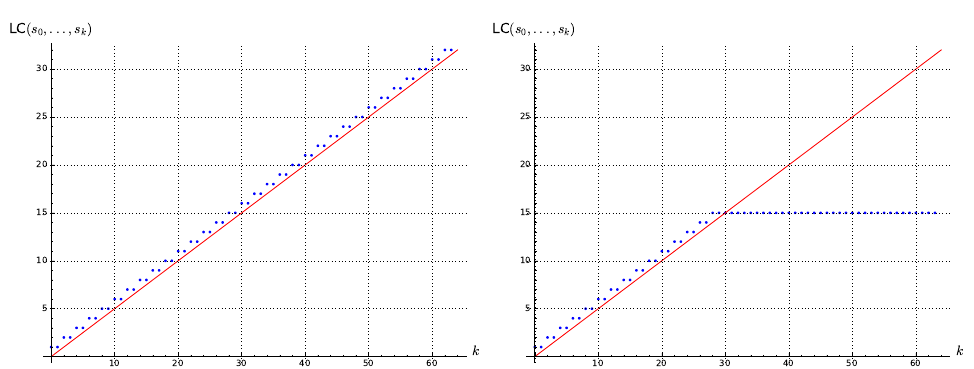
Figure 6: Linear complexity profiles for a random sequence and for the NTT of a low Hamming weight